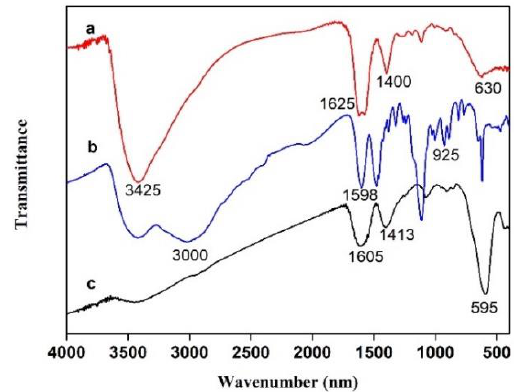
Figure 3. FT-IR spectra of ( a ) FeO x / ZnS NPs, ( b ) ZnS: Mn 2 + QDs@MEA and ( c ) FeO x @COOH nanoparticles. Figure 3 . FT-IR spectra of ( a ) FeO x /ZnS NPs, ( b ) ZnS: Mn 2+ QDs@MEA and ( c ) FeO x @COOH nanoparticles.